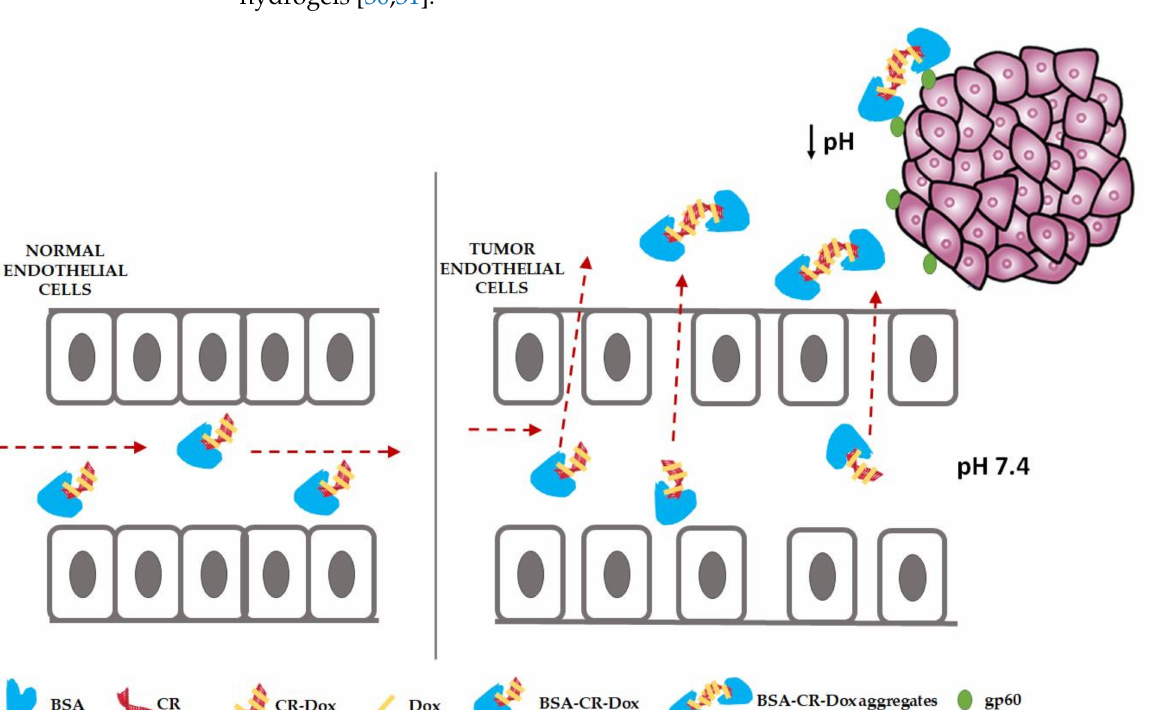
Figure 1. Endothelial cells of a healthy vessel are tightly adjacent to each other vs. capillary in tumor tissue with “relaxed epithelium” (EPR) (albumin–Congo red–doxorubicin: BSA–CR–Dox passive transport). Active transport is mediated by the BSA–CR–Dox binding to SPARC glycoprotein (gp60), which penetrates tumor cells. Additionally, the formation of aggregates after lowering the pH in the tumor environment is visible, which facilitates the release of Dox. Arrows indicate the direction in which the complex is